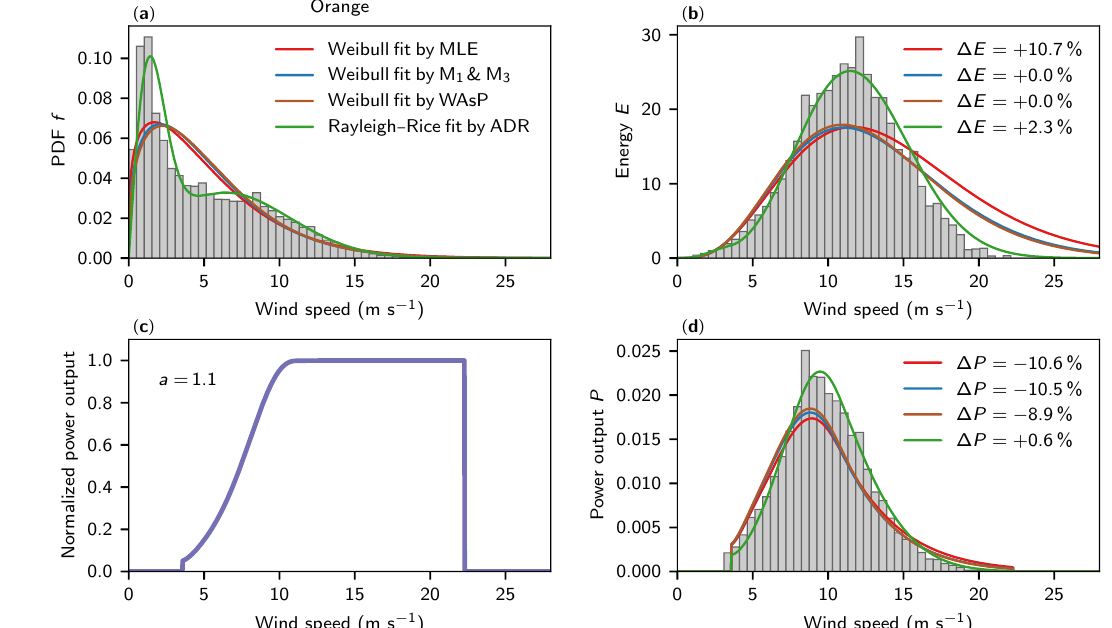
Figure 5. Representation of the energy and production calculations at Orange, representative of a bimodal case. Same description as Fig.